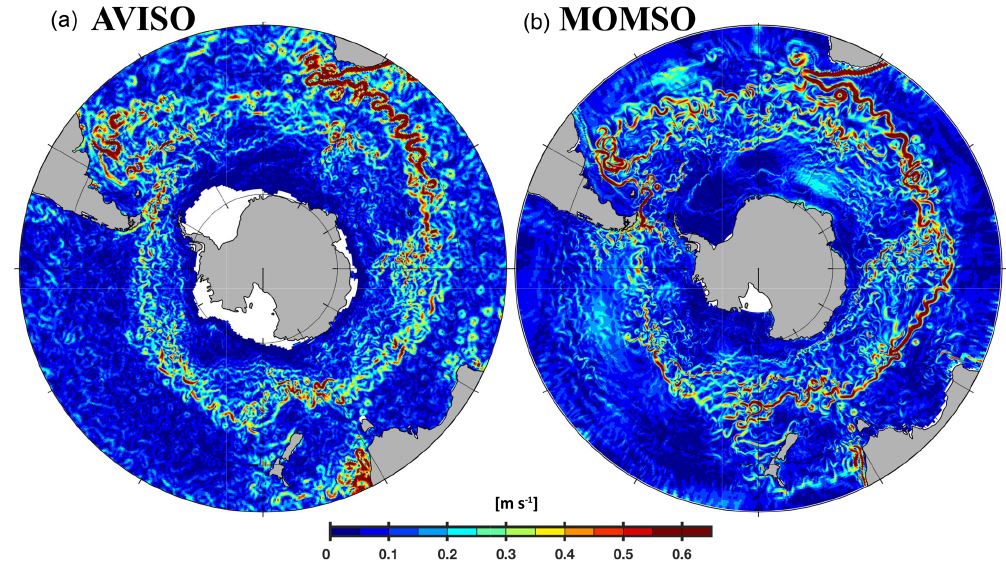
Figure 5. Magnitude of surface velocities. Panels (a) and (b) show typical snapshots as observed from space (Aviso, 3 May 1995) and as simulated (MOMSO, 3 May of nominal year 2020), respectively.